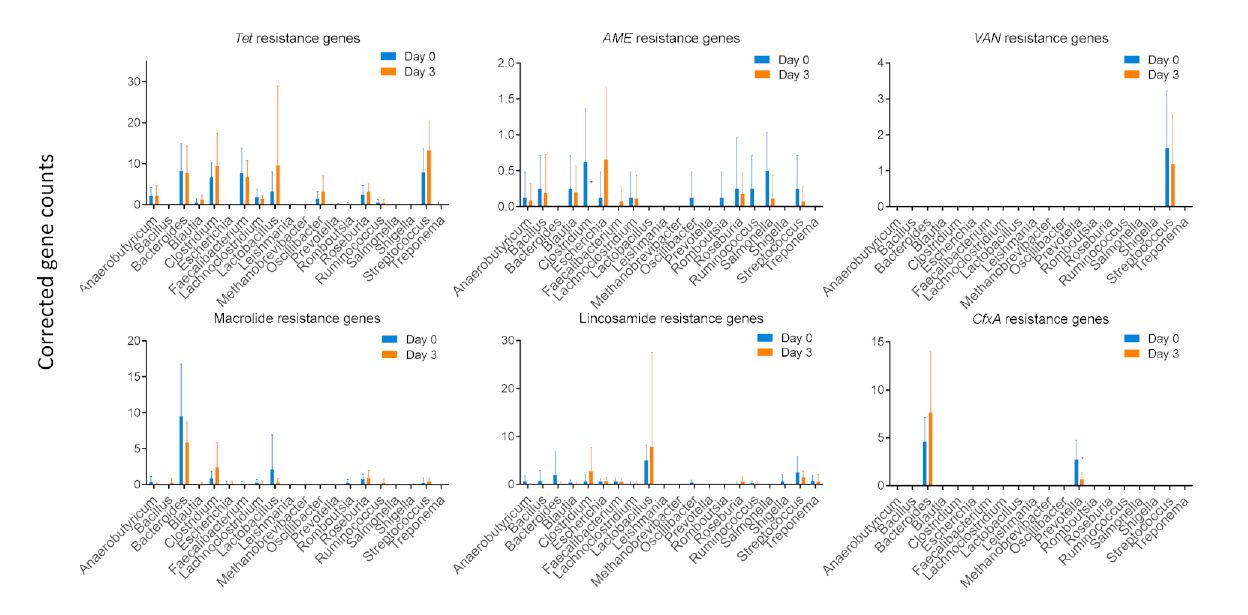
Figure 5. Bar plots (+standard deviation), showing the mean ( n = 8) resistance gene counts corrected to the relative (pre-treatment to post-treatment, i.e., 9 h after the last dose of the daily intramuscular administration of 3 mg · kg − 1 body weight of ceftiofur for 3 consecutive days) base counts of the top 20 genera. D0 = day 0, D3 = day 3. Tet = tetracycline, AME = aminoglycoside-modifying enzyme, Van = vancomycine, CfxA = beta-lactamase. Significance codes: ‘*’ p -value < 0.05.